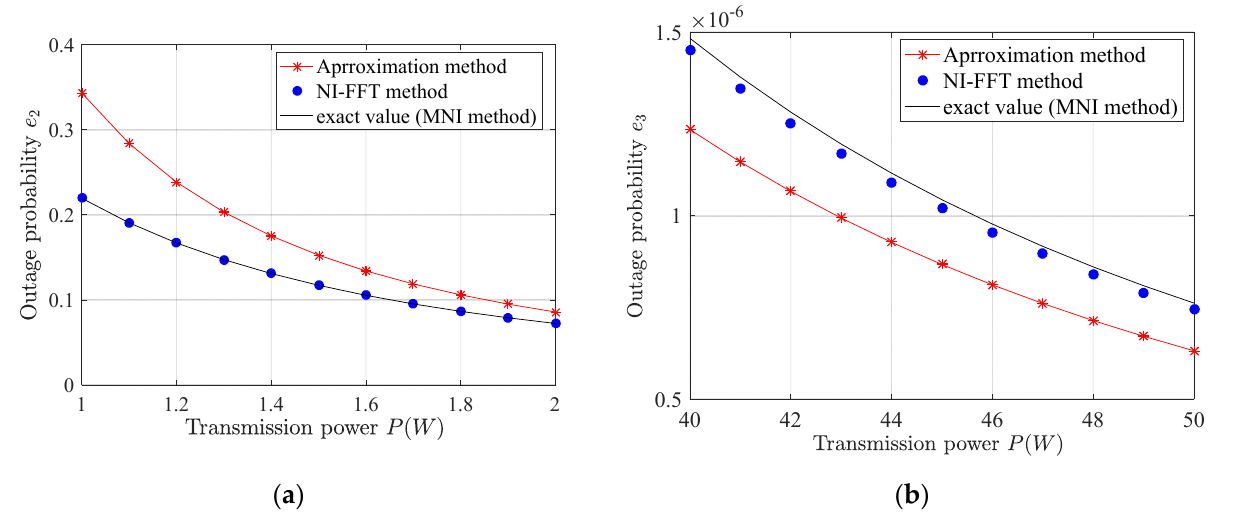
Figure 4. Comparison between the approximate and exact outage probability for the Rayleigh fading channel: ( a ) with K = 0, R = 1, L = 2; ( b ) with K = 0, R = 1, L = 3. As can be seen from Figure 4, the outage probability calculated by the NI-FFT method is almost the same as the exact value obtained by the MNI method. The results of the proposed NI-FFT method under different rates R are shown in Figure 5. It also proved that the proposed NI-FFT method can calculate the outage probability of IR-HARQ more accurately. Furthermore, when L increases, the NI-FFT method is still applicable.